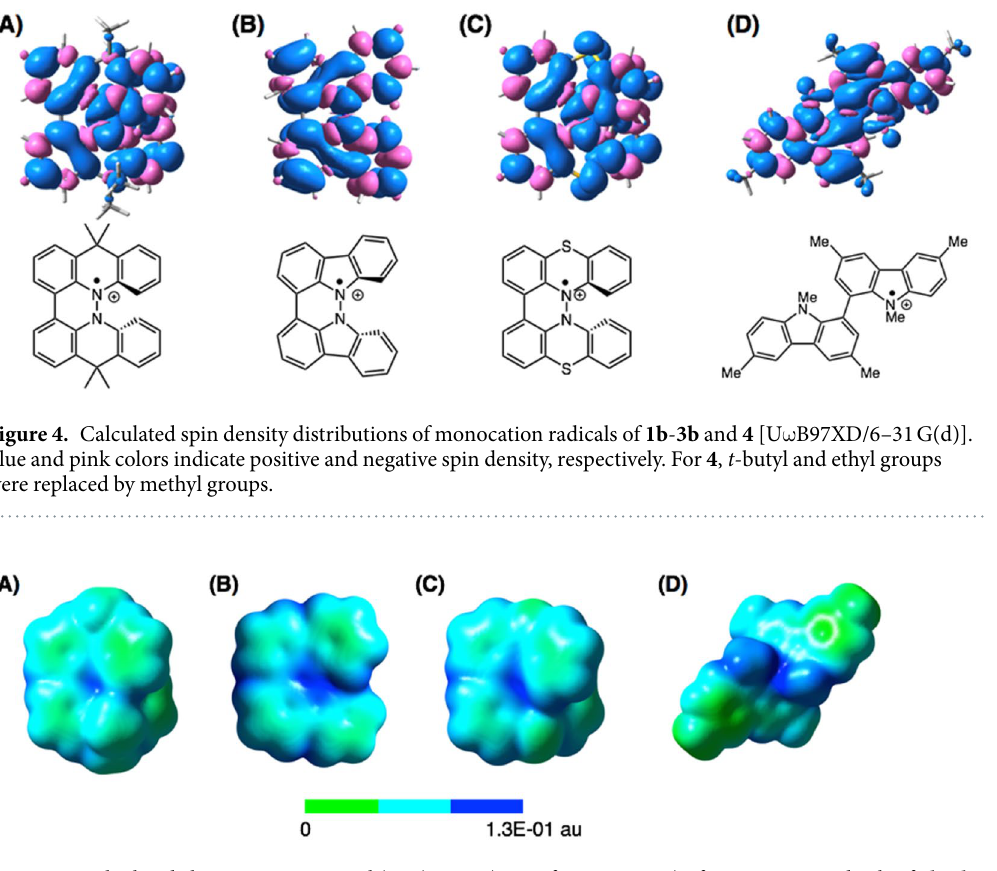
Figure 5. Calculated electrostatic potential (ESP) maps (isosurface at 0.02 au) of monocation radicals of 1b - 3b and 4 [U ω B97XD/6-31